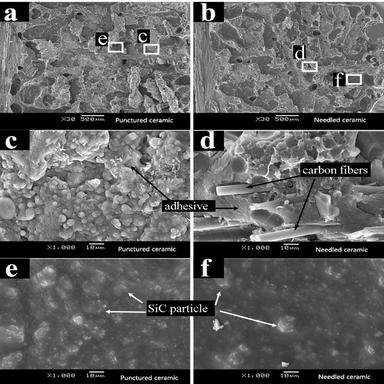
SEM images of the breakage surface of the punctured ceramic/needled ceramic bonding pairs (a) surface of the punctured ceramic; (b) surface of the needled ceramic (c) and (e) magnified images of some typical areas in Fig. 9(a) and (d) and (f) magnified images of some typical areas in Fig. 9(b), respectively.